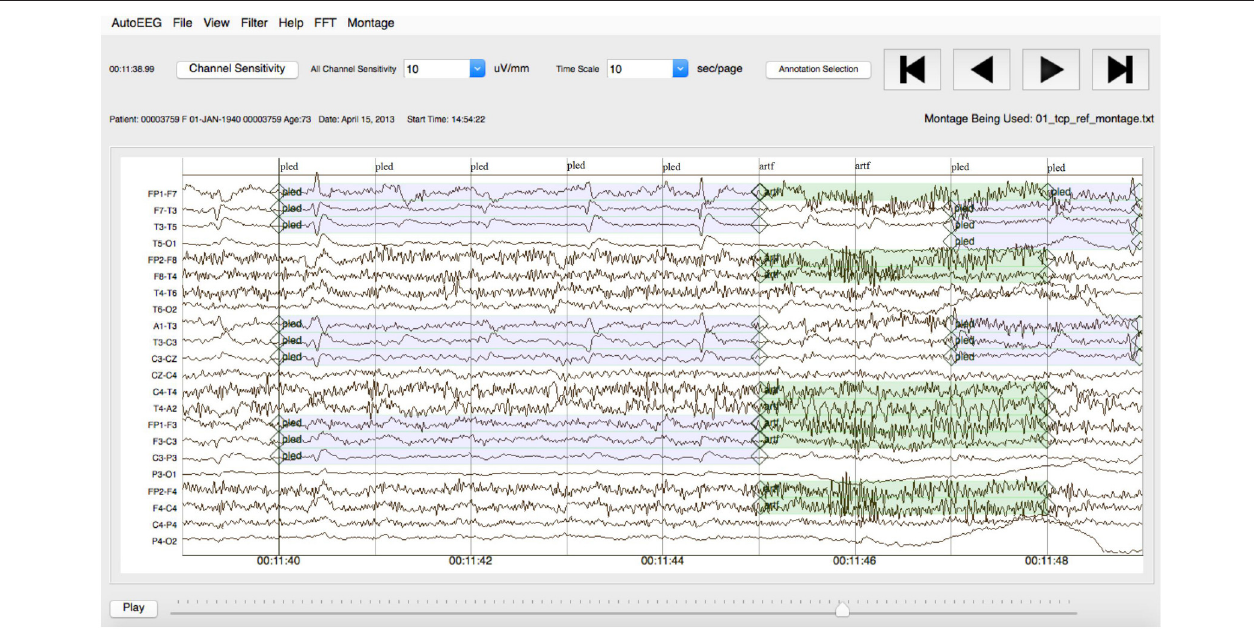
FIGURE 3 | An example demonstrating that the reference data is annotated on a per-channel basis.